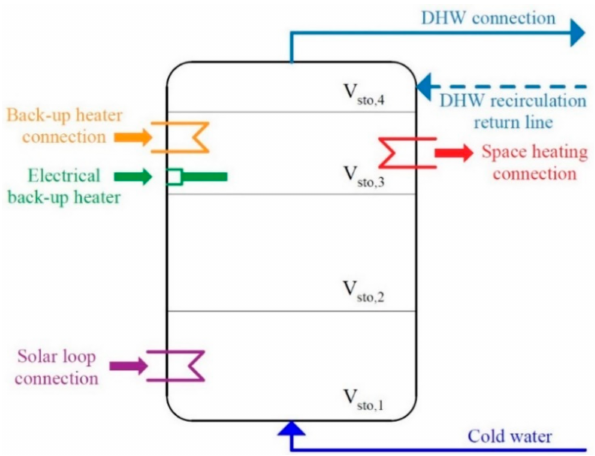
Figure 5. The schematic of the storage tank